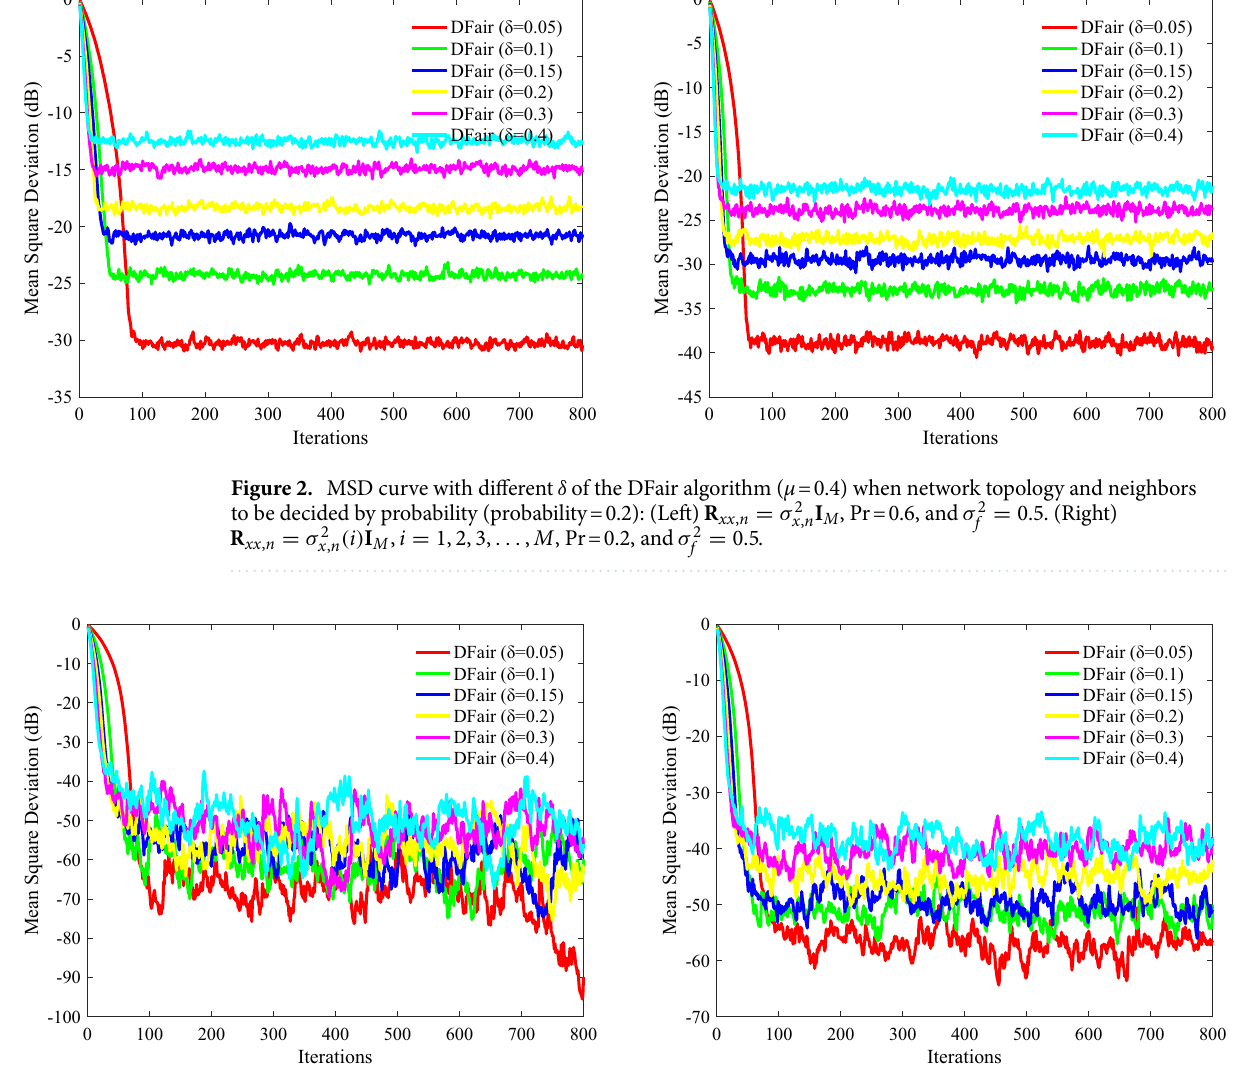
Figure 3. MSD curve with different δ of the DFair algorithm ( μ = 0.4) when network topology and neighbors to be decided by closeness in the distance (radius = 0.3): (Left) R xx , n is a diagonal matrix with possibly different diagonal entries chosen randomly, Pr = 0.4, and σ 2 f = 0.5 . (Right) R xx , n = σ 2 x , n ( i ) I M , i = 1, 2, 3, . . . , M , Pr = 0, and σ 2 f = 0.5